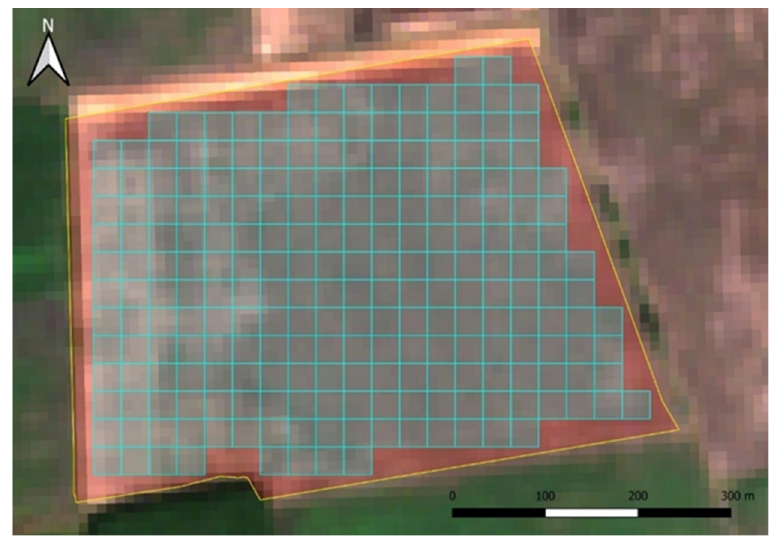
Figure 4. Subdivision of a parcel into 30 × 30 m units for data augmentation.